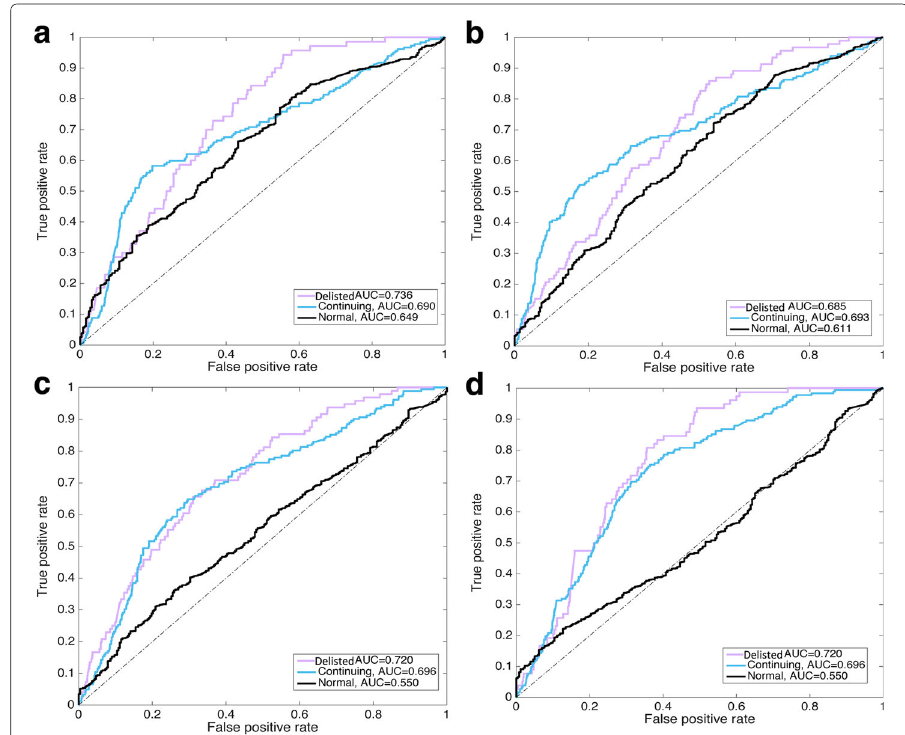
Fig. 7 ROC analysis of three groups of stocks in a 2013-2014, b 2014-2015, c 2015-2016 and d 2016-2017